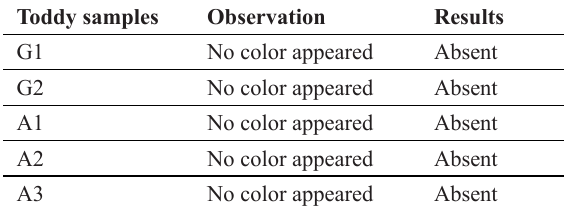
Table 4: Test for the presence of paraldehyde in toddy